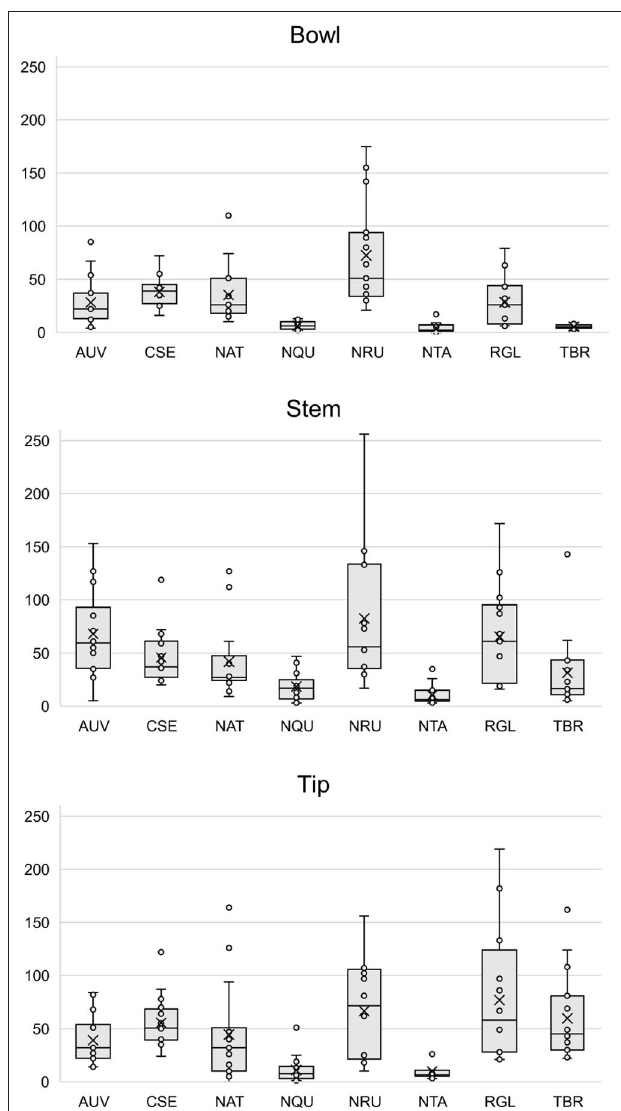
FIGURE 6 | Box plots of the number of mass spectral features detected in each pipe section (i.e., bowl, stem, and tip) by species. Each point represents a sample. The × and horizontal line in each box plot indicate the mean and median, respectively. AUV , A. uva-ursi ; CSE , C. sericea ; NAT , N. attenuata ; NQU , N. quadrivalvis ; NRU , N. rustica ; NTA , N. tabacum ; RGL , R. glabra ; and TBR , T. brevifolia